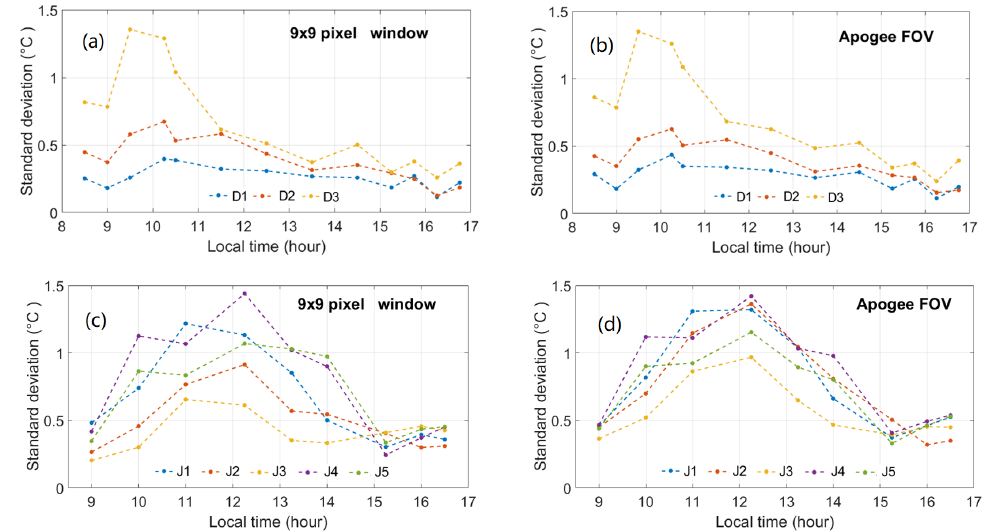
Figure 3. Standard deviation of diurnal UAV-based land surface temperature (LST) within 9 × 9 pixels (90 × 90 cm) ( a , c ) and Apogee field-of-view (FOV) windows ( b , d ) for the 3 stations (D1–D3) on 13 December 2016 and for the 5 stations (J1–J5) on 31 January